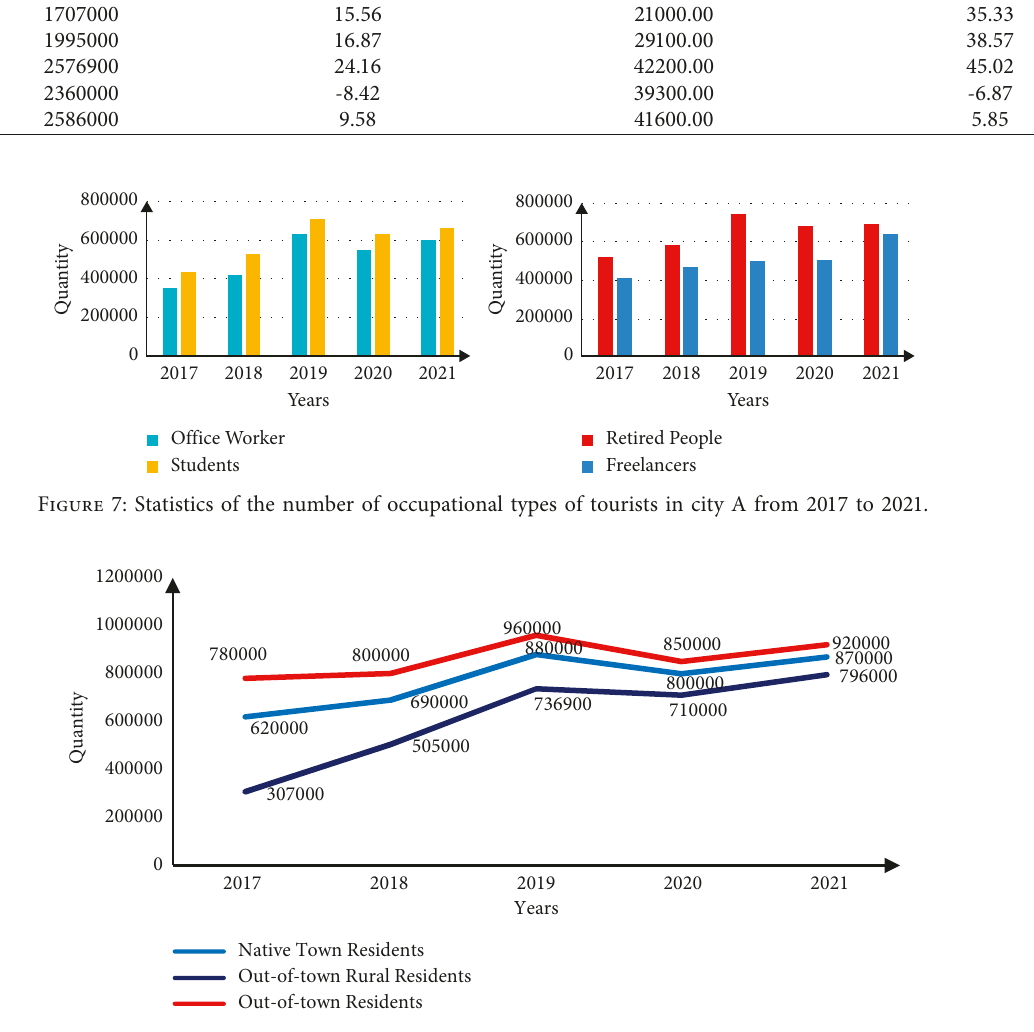
Figure 8: The number of tourists in city A from 2017 to